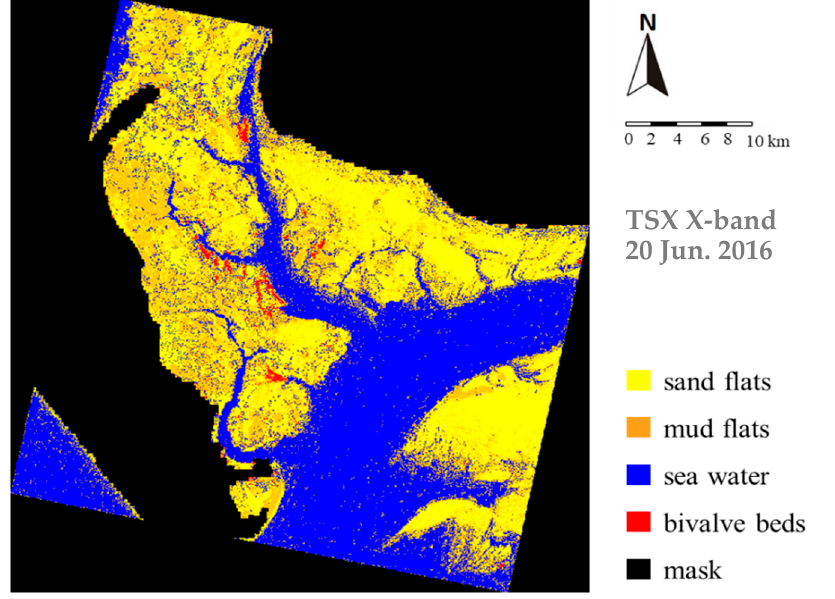
Figure 7. Same as Figure 5, but for TSX X-band dual-co-pol SAR data acquired on 20 June 2016 at 05:50 UTC, 32 min before the low tide.